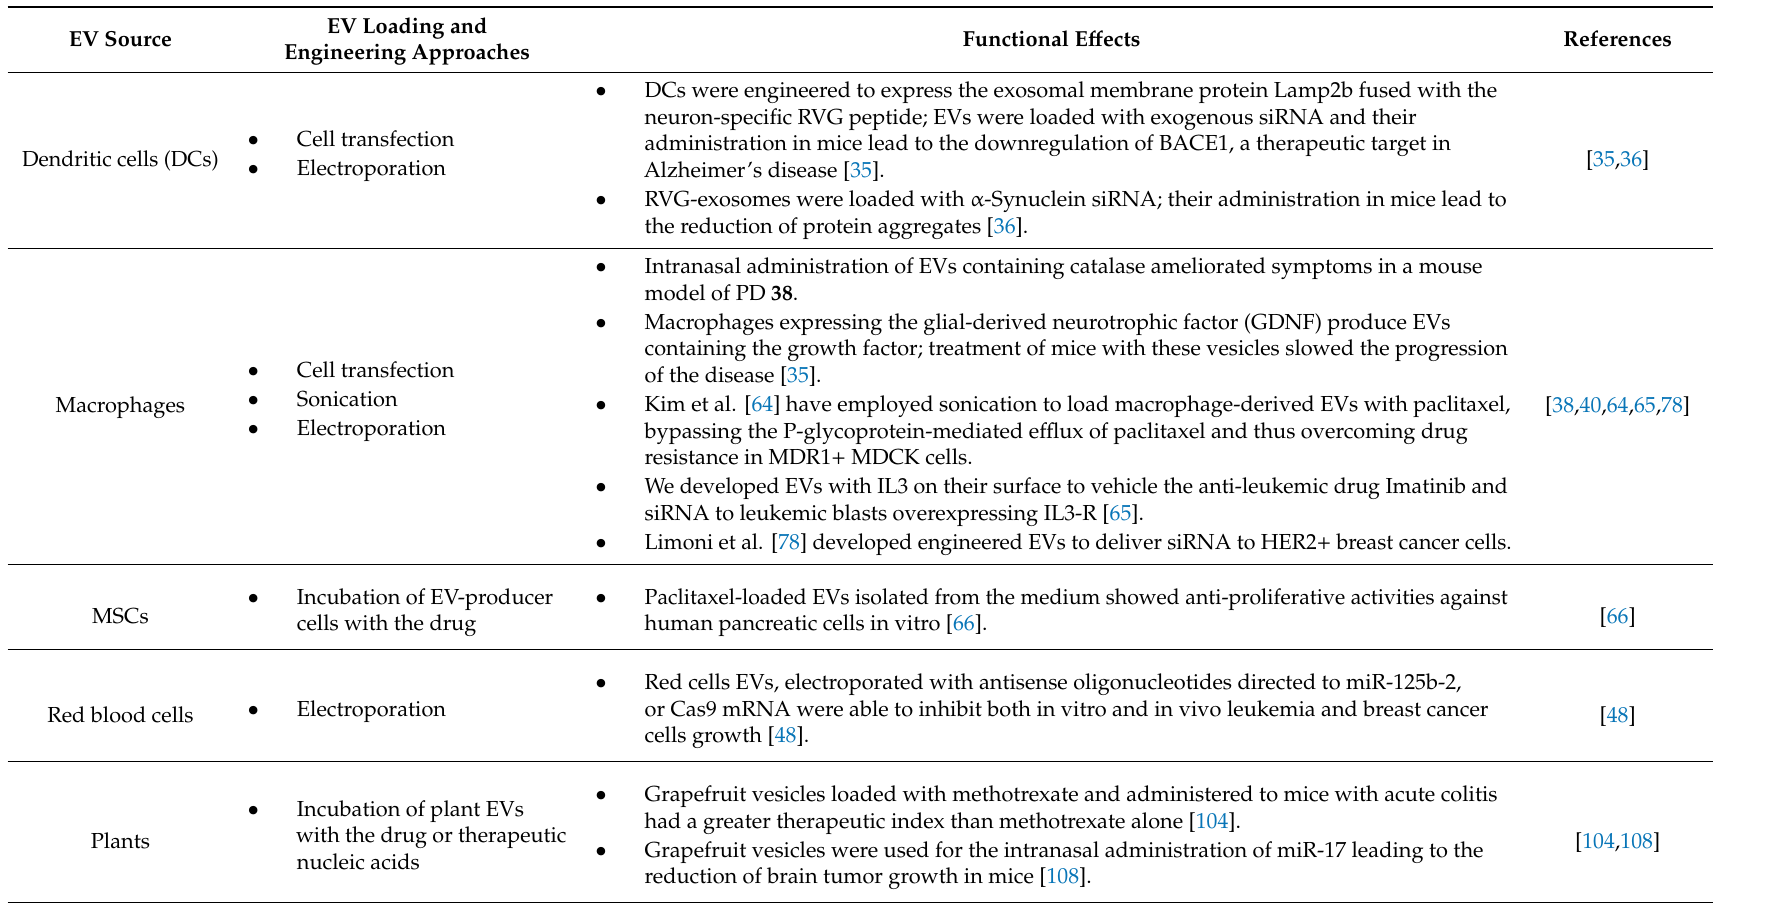
Table 1. Experimental studies on the use of animal and plant EVs for therapeutic